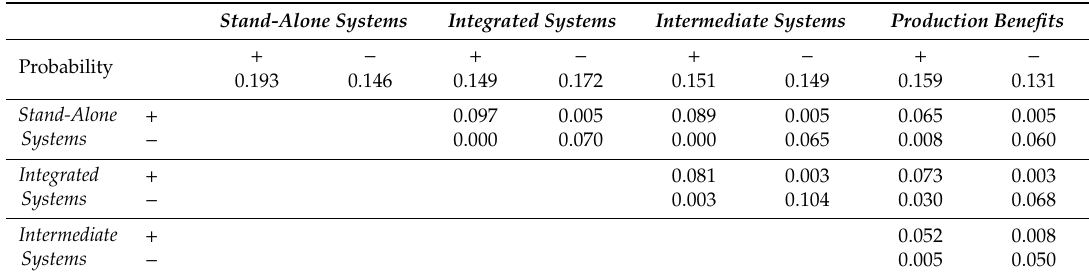
Table 11. Sensitivity